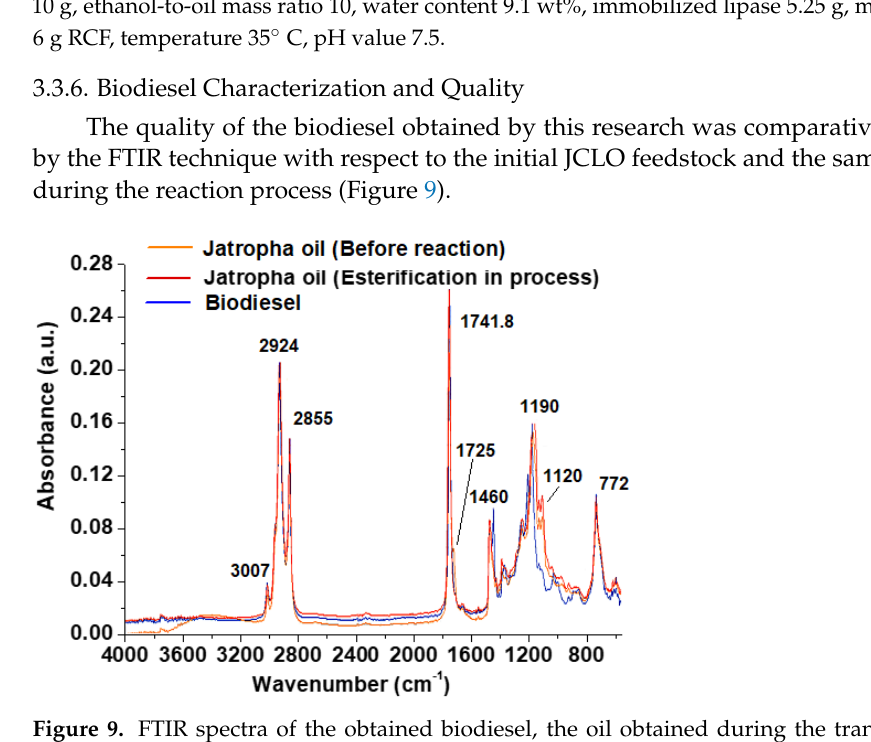
Table 5. Quality of the biodiesel obtained via transesterification of JCLO using microencapsulated recombinant lipase as biocatalyst.